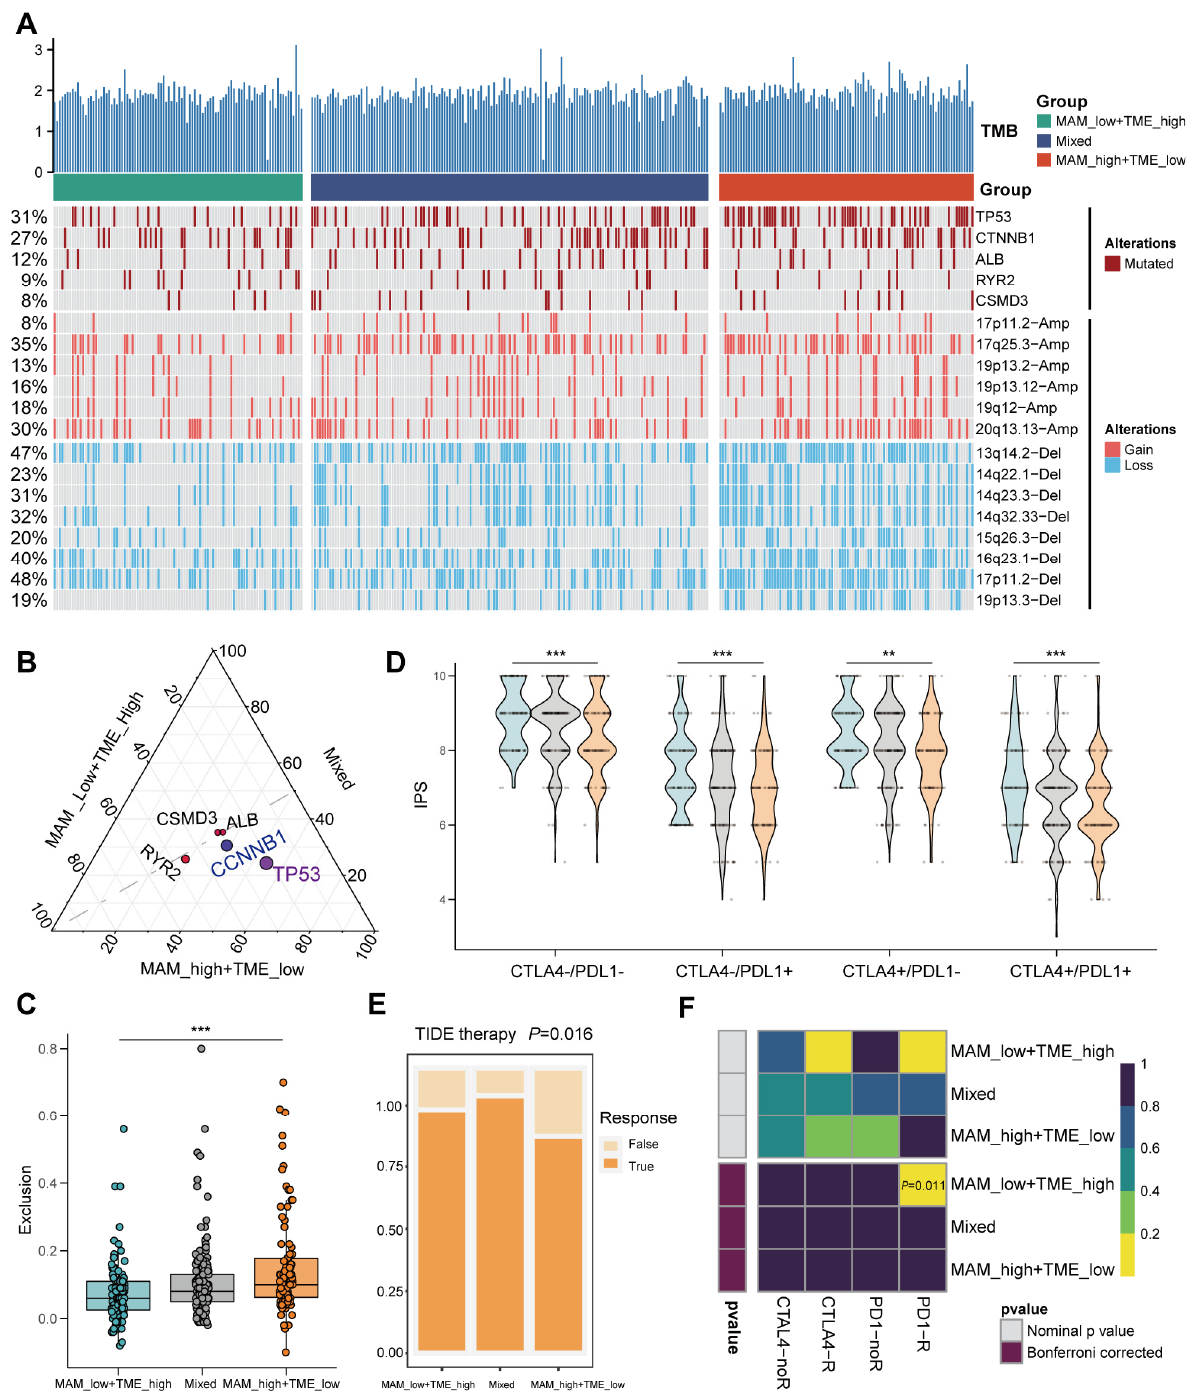
Figure 7. Mutation landscape and response to ICB. ( A ): Landscape of genomic mutations and CNV data of HCC in the low MAM/high TME group, mixed group, and high MAM/low TME group in the TCGA dataset. ( B ): Triangle plot and prominent dots of the top five mutated frequencies between the combined groups. ( C ): Boxplot of exclusion between the combined groups in the TIDE platform. ( D ): Relative probability of the effectiveness of anti-PD-1 and anti-CTLA-4 therapies in patients with HCC in the combined groups. ( E ): Proportion of HCC patients with TIDE response of the combined groups. ( F ): Combined analysis of TIDE and submap to predict the response of the combined groups to ICB therapy. ** p ≤ 0.01; *** p ≤